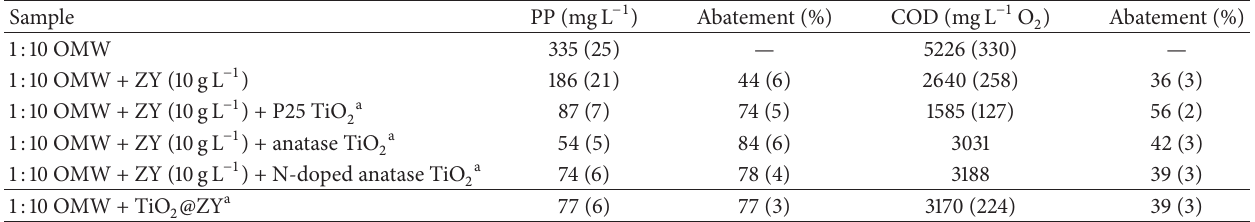
Table 5: PP and COD values in 1:10 OMW before and after photocatalytic treatment under solar simulated light using different TiO 2 -based photocatalysts ( 𝑛 = 3